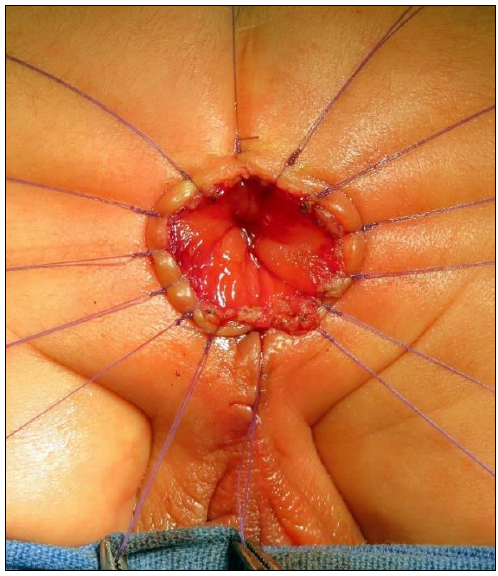
Figure 3. Final step of MPSARP: anoplasty performed with no tension, before cutting off sutures.